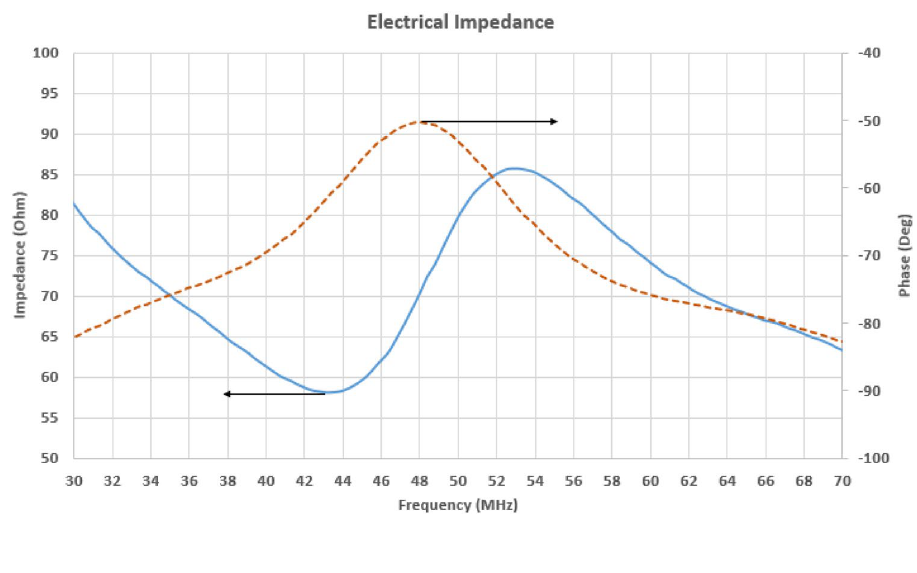
Fig. 4 The pressure profile in response to impulse voltage resulting from the KLM model. The red is the frequency spec- trum of the